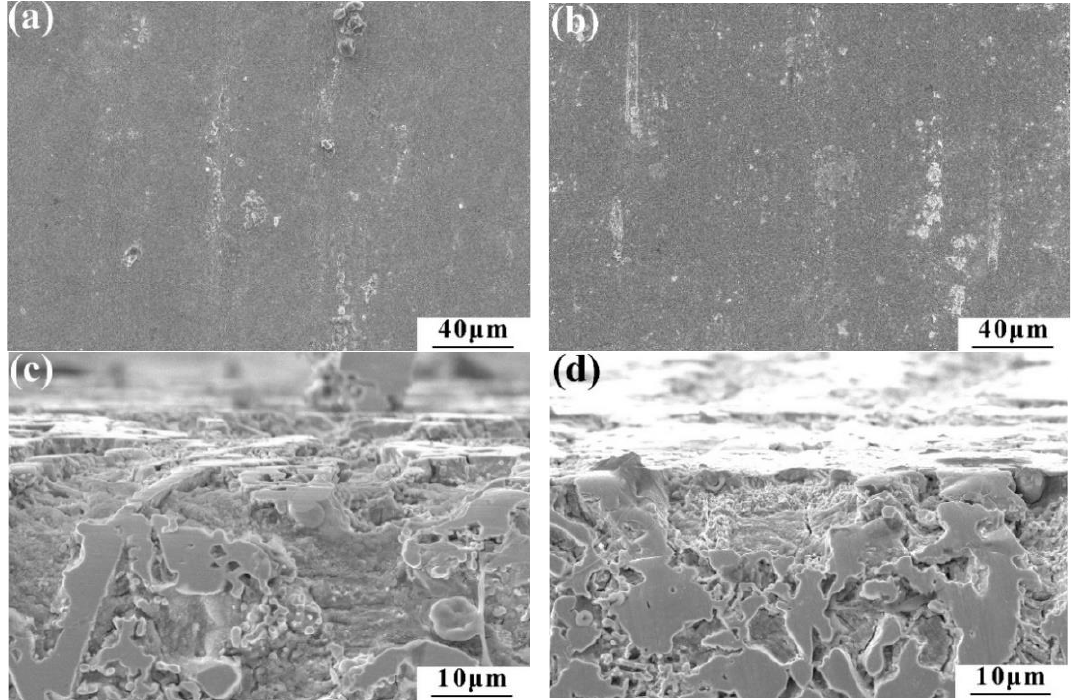
Figure 12. Wear loss of alloy A and alloy B.